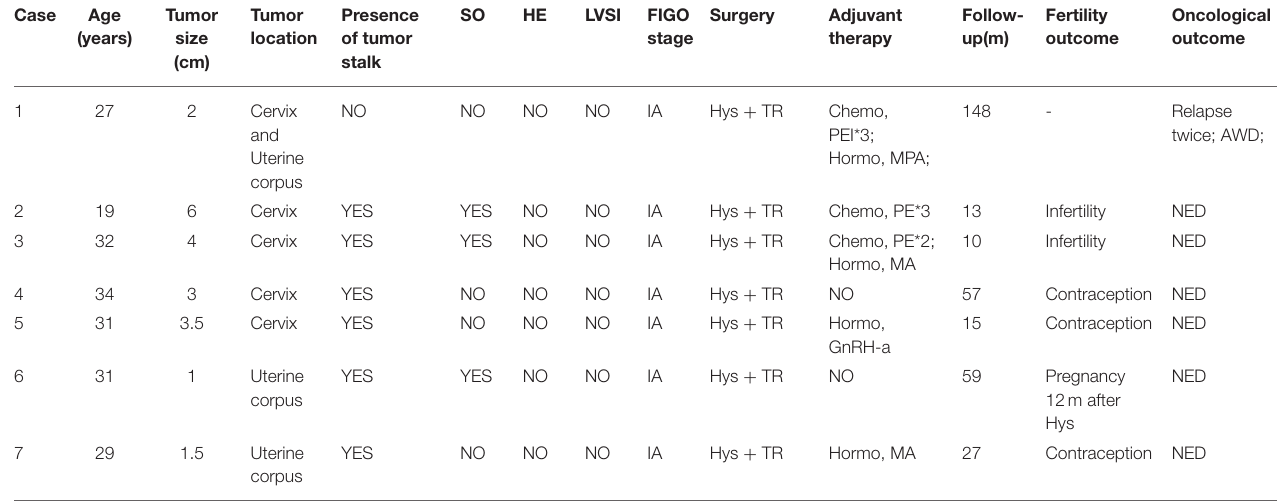
Surgery Adjuvant stage